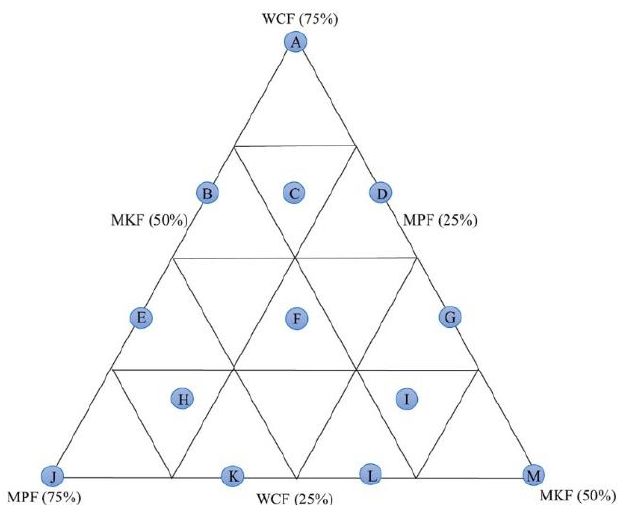
Figure 1. Point of Design Simplex-lattice. White Corn Flour (WCF), Mango Peel Flour (MPF) and Mango Kernel Flour (MKF).